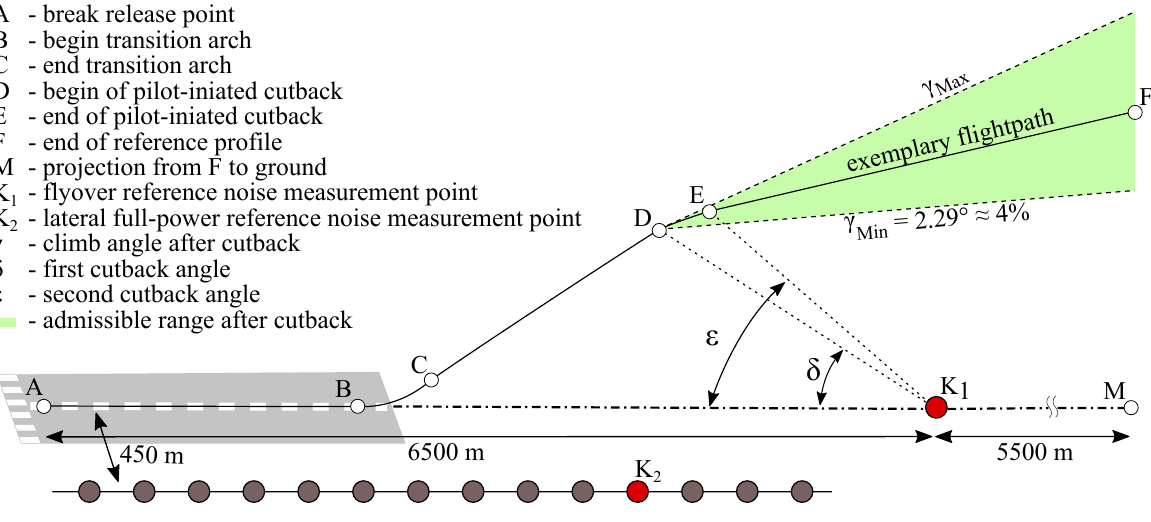
Figure 1. Take-Off Reference profile of subsonic aircraft for noise certification with flyover (K1) and lateral full-power reference measurement point (K2) and runway, adjusted from